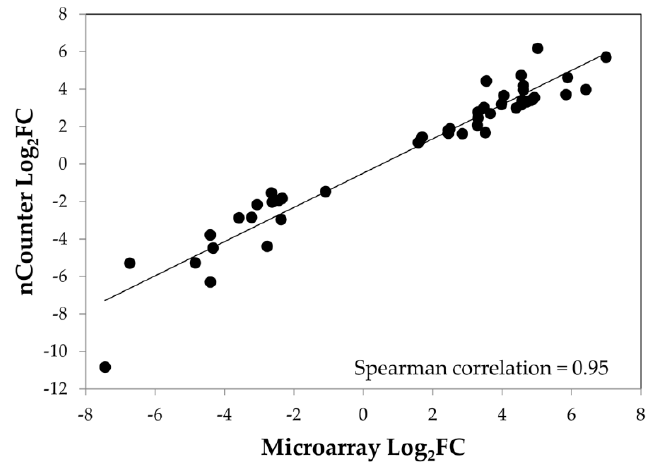
Figure 7. Correlation of microarray and nCounter NanoString data for selected DEGs. The Spearman rank correlation of the log 2 differences between the microarray and NanoString nCounter ® measurements for the 19 selected DEGs is presented. The mean of the log 2 FC value between the PSTVd-infected and mock-inoculated samples was calculated from three or two biological replicates.